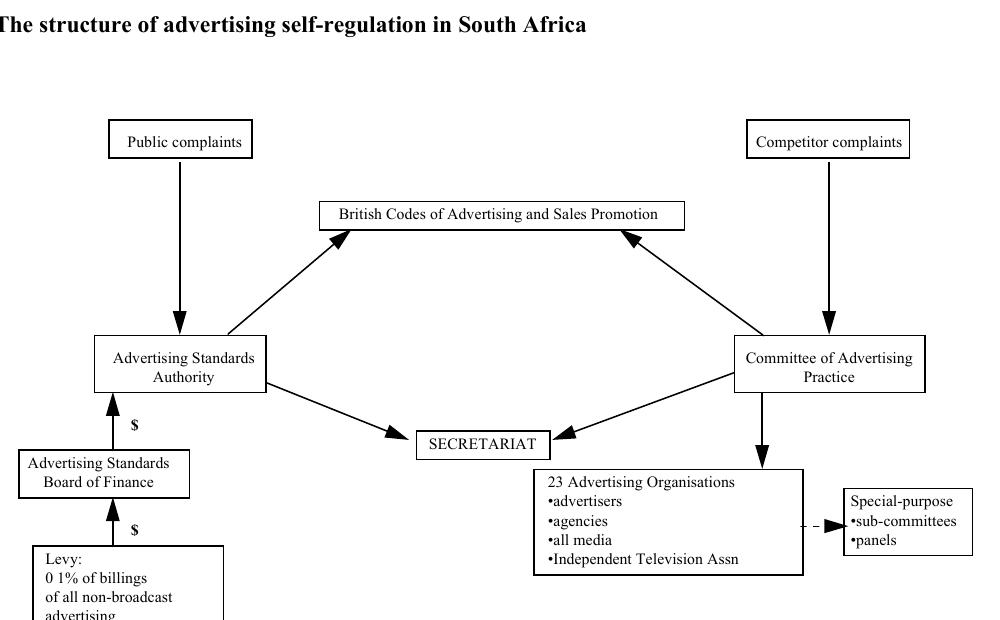
Figure 4: The structure of advertising self-regulation in the United